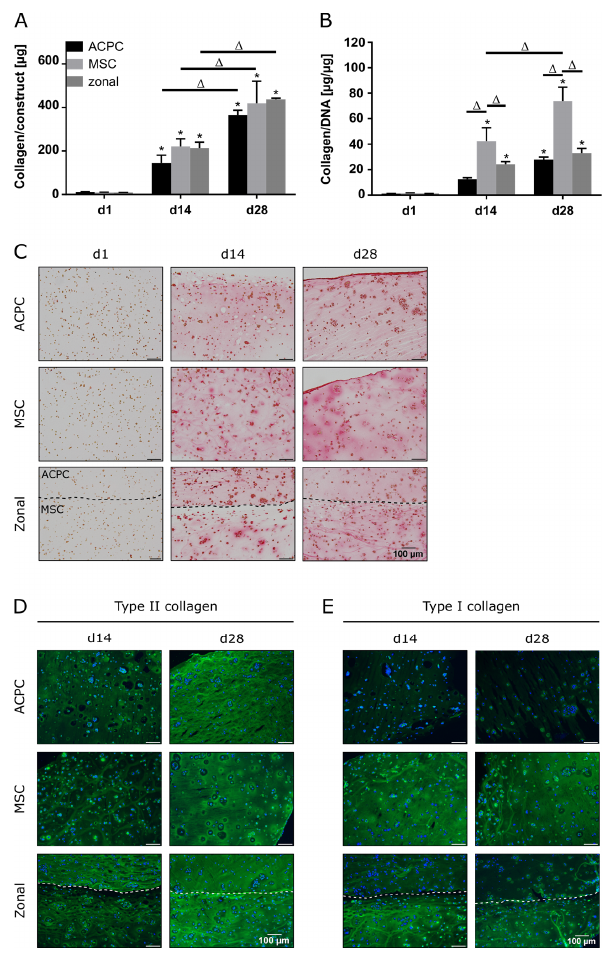
Figure 2. Collagen production in ACPC, MSC, and zonal constructs under normoxic conditions. Biochemical, histological, and immunohistochemical analysis of collagen in agarose hydrogel constructs, seeded with 20.0 × 10 6 cells mL − 1 , after 1, 14, and 28 days of chondrogenic di ff erentiation under normoxic conditions. ACPCs and MSCs were either cultured alone or in zonally layered co-culture constructs. ( A ) Production of total collagen (collagen / construct) and ( B ) collagen normalized to DNA (collagen / DNA). Data are presented as means ± standard deviations ( n = 3 biological replicates). Note: (*) indicates statistically significant di ff erences between a d14 or d28 value and the corresponding d1 value of the same group ( p < 0.05); ( ∆ ) indicates statistically significant di ff erences between groups, or within a group between time points ( p < 0.05). ( C ) Histological picrosirius red staining for visualization of produced collagen. Immunohistochemical staining for ( D ) type II collagen and ( E ) type I collagen. In zonal constructs, the upper layer contained ACPCs and the lower layer contained MSCs (indicated by the dashed